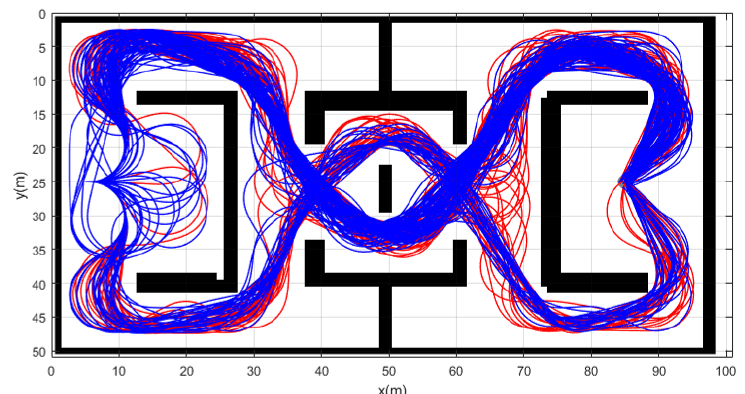
Figure 13. Resultant trajectories from simulation 6. Red lines: DT-RRT, Blue lines: